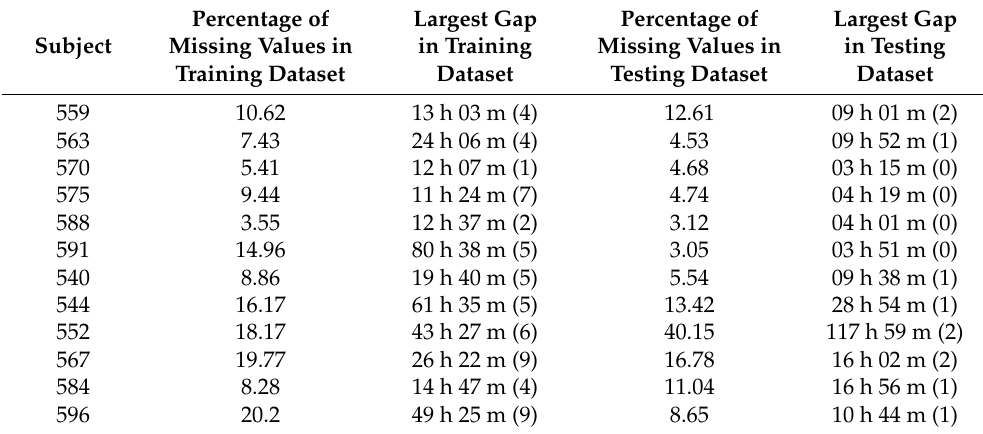
Table 1. Percentage of missing values in the CGM feature for each subject. In parentheses is the number of gap intervals exceeding six